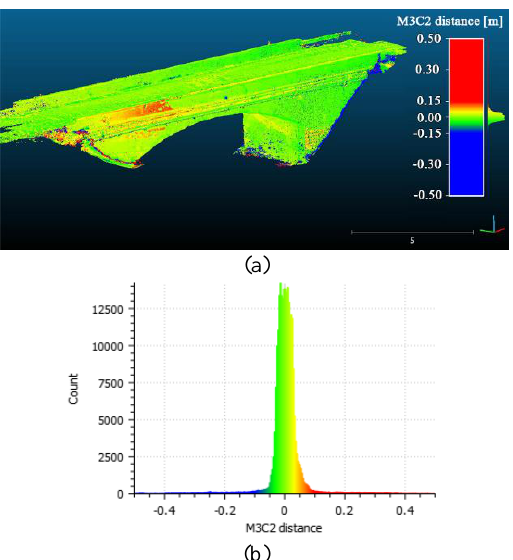
Figure 12. a) Distances between the UAV-LiDAR integrated point cloud and the TRAD integrated point cloud; b)